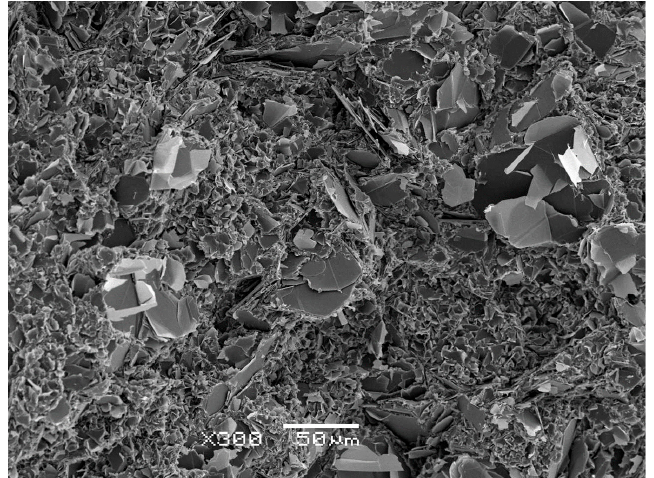
Figure 9. Scanning electron micrograph of epoxy-BN hybrid system ETLBN80/2-50. Scale bar is 50 µm.